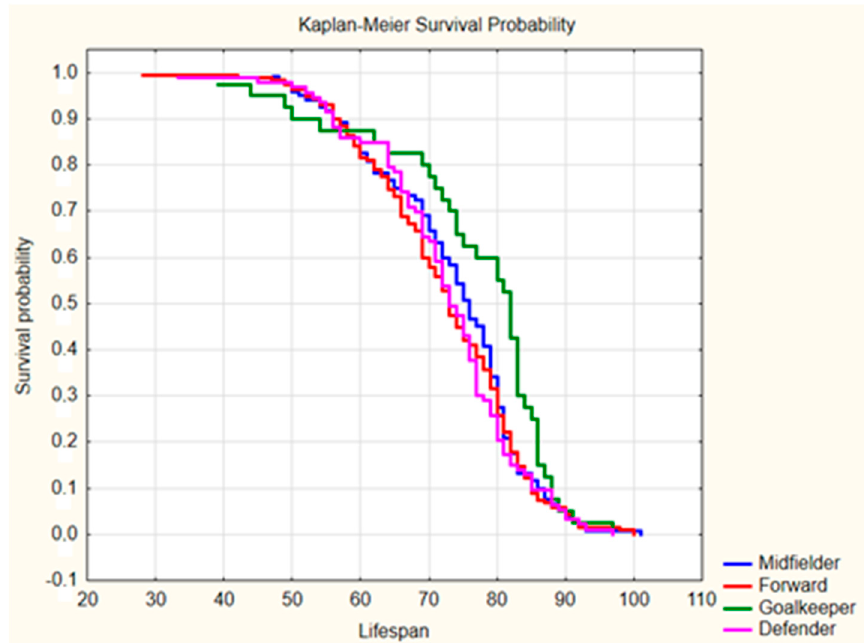
Figure 1. Kaplan–Meier survival probability curves for players who participated in the World Cup tournaments of 1930, 1934, and 1938. Source: self-calculated data based on www.worldfootball.net.